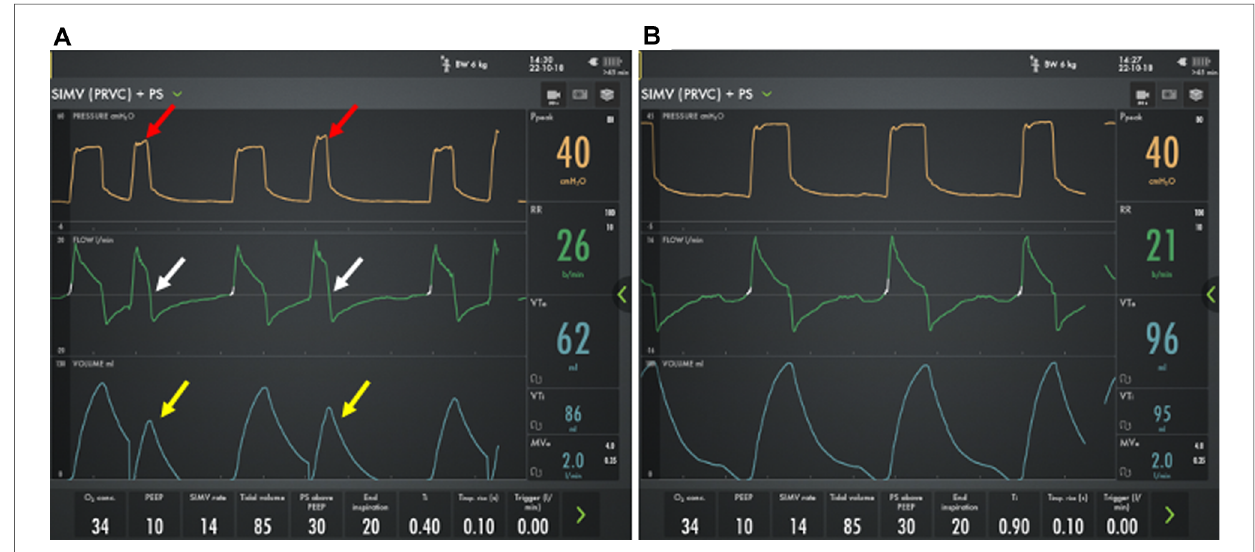
FIGURE 5 Ventilator waveforms from an 8 month old former 24 week premature infant with severe bronchopulmonary dysplasia using two different inspiratory time strategies. ( A ) Using a short (0.4 s) inspiratory time, there is incomplete fi lling (white arrows) with reduced tidal volume (yellow arrows), increased respiratory rate, and increased peak pressures (red arrows) compared with ( B ) a long (0.9 s) inspiratory